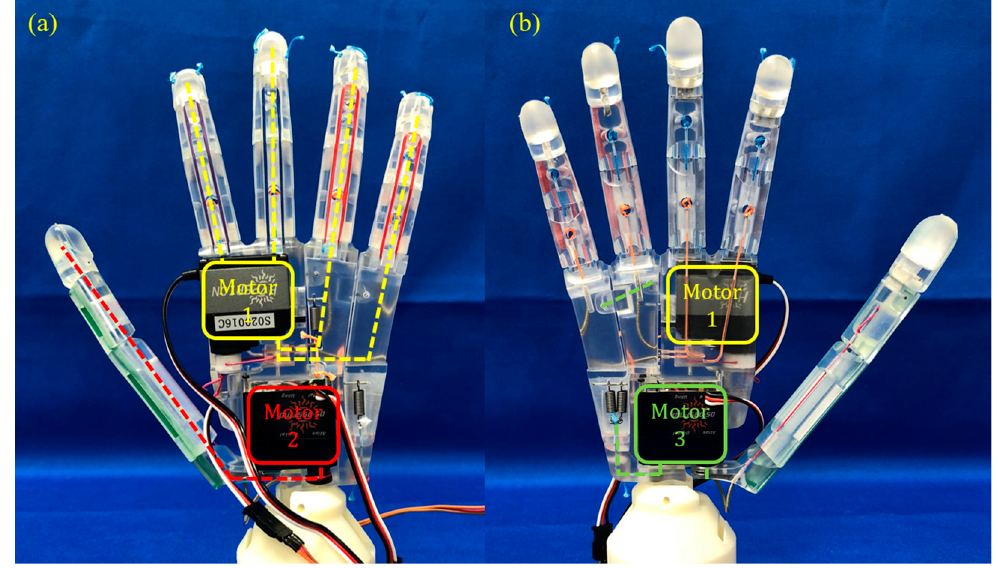
Figure 3. Assembled prosthetic hand: ( a ) back view; ( b ) front view. The corresponding tendon configurations are sketched with dotted lines (colored the same as each motor).